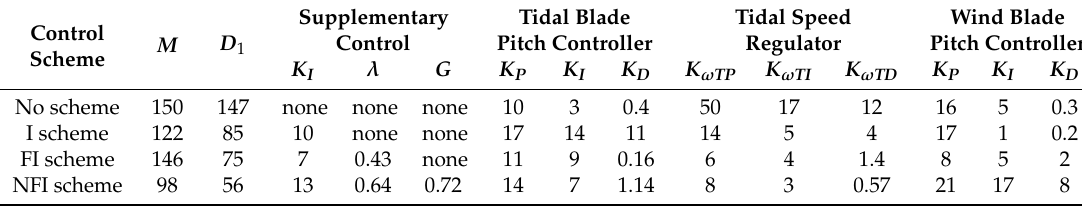
Figure 15. Change in wind power when the system was subjected to test 1. Table 3. Microgrid control schemes parameters in test